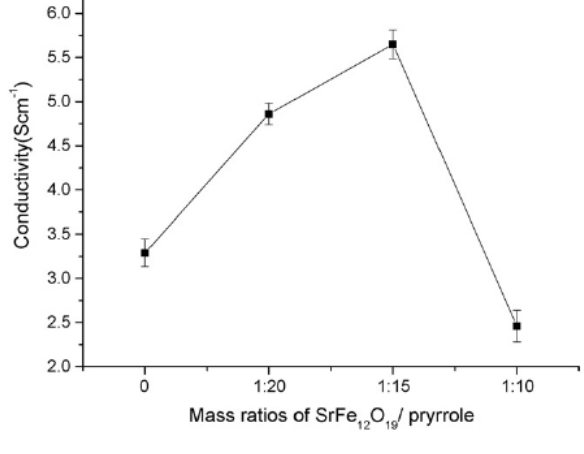
O nanocomposite (adapted from 12 19